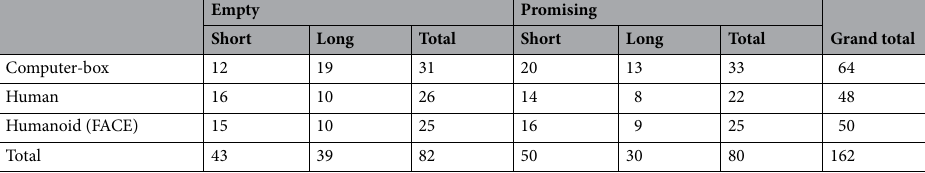
Table 1. Experimental conditions. This table classifies the number of observations collected in our study according to the type of counterpart the human participants confront with (i.e. computer-box, human, and humanoid) and the type of sentence they have to listen to (i.e. cointaining a promise or not, either a short or long sentence).